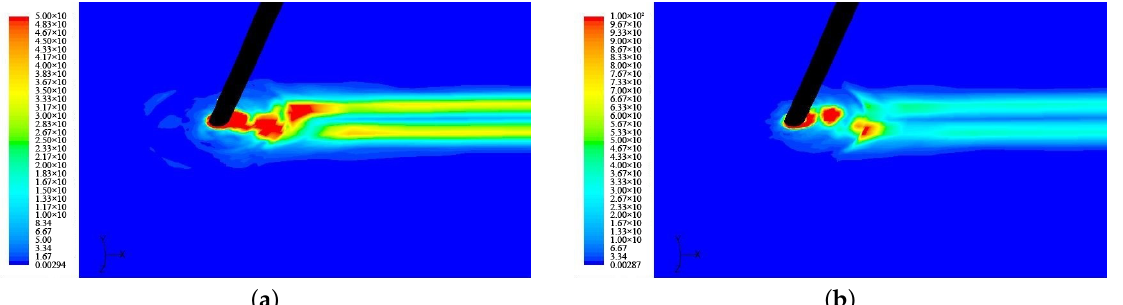
Figure 16. Cloud map of vorticity at 1 m underwater depth at different times: ( a ) at the moment of 14 s, the vorticity cloud map of 1 m water depth; ( b ) at the moment of 16 s, the vorticity cloud map of 1 m water